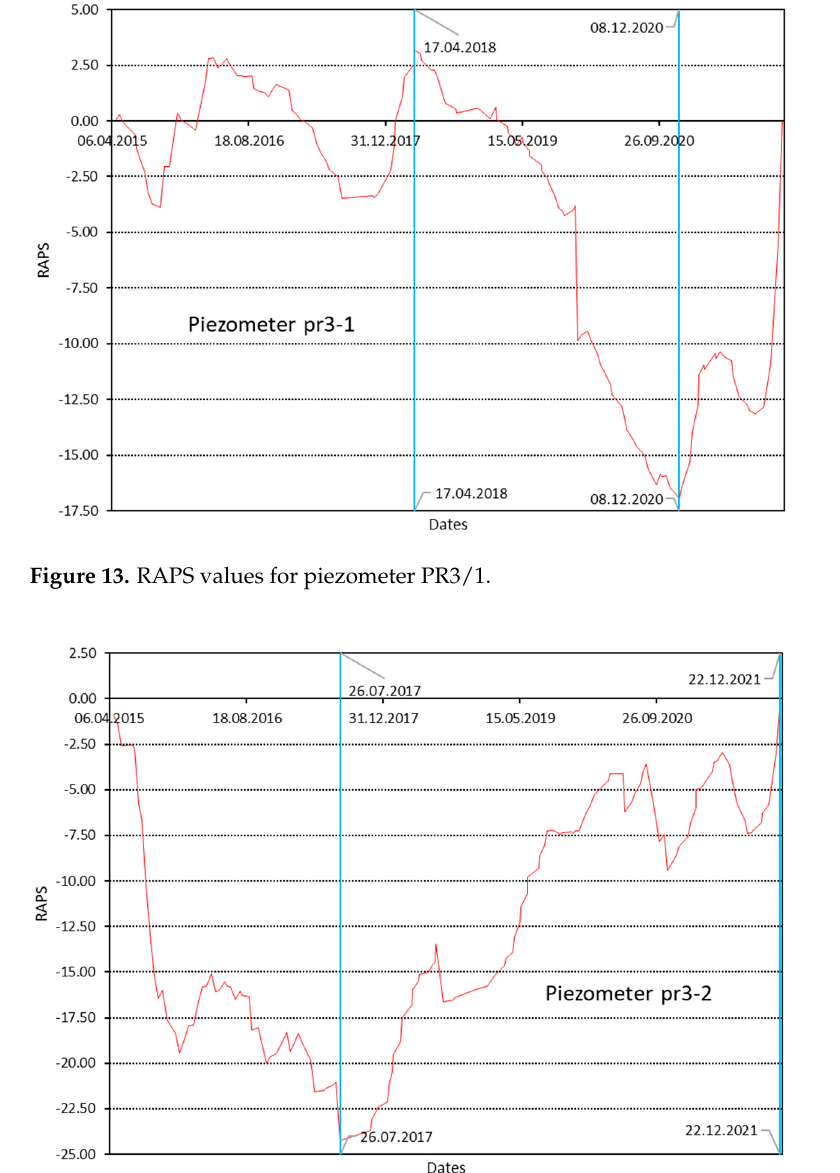
Figure 12. RAPS values for the headwater level of the accumulation lake.